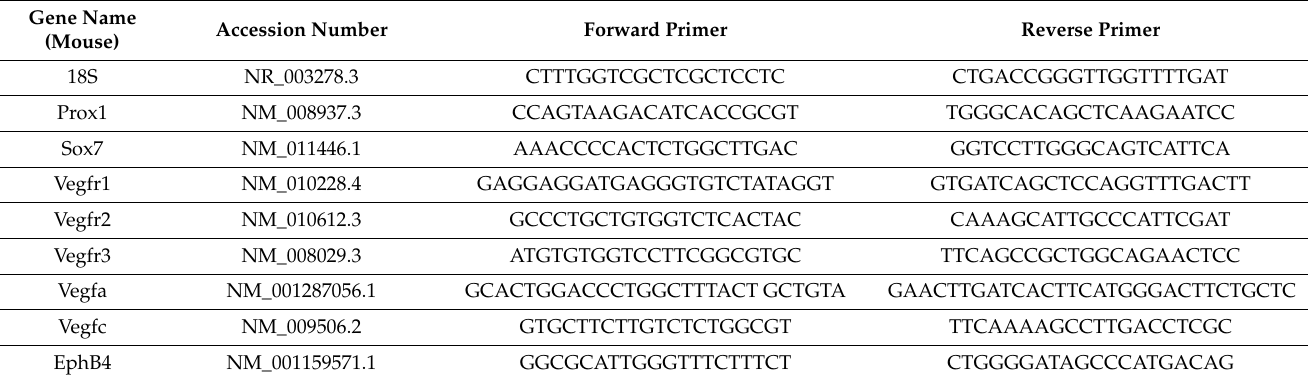
Table 1. Primers used for